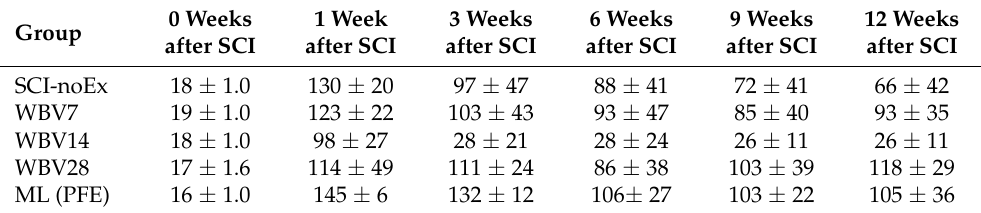
Table 2. Time course of the changes in stepping ability of the experimental groups, as assessed by the foot-stepping angle (FSA). Group’s mean values ± SD are shown.